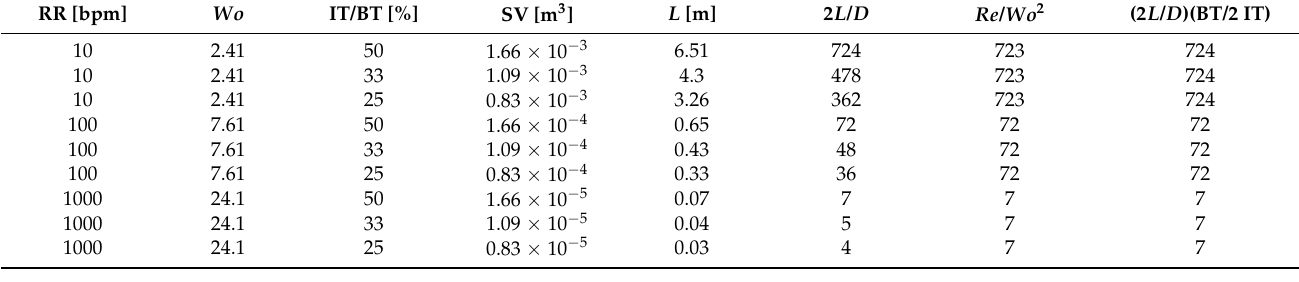
Table 3. Flow regime parameters evaluated at the upper tracheal section (Plane 1): Re / Wo 2 , dimensionless stroke length 2 L / D and modified dimensionless stroke length ( 2 L / D ) (BT/2 IT). Stroke length ( L ) was calculated as: SV/ ( π D 2 /4 ) , where SV = stroke volume and D = tracheal diameter = 0.018 m. SV was obtained by integrating the time-varying volumetric flow rate at the inlet ( Q in ) over a breathing cycle for each Wo and IT/BT condition, where Q in ( t ) = V inlet ( t ) A in (prescribed inlet velocity profile, V inlet ( t ) , refer to (5) and (6)). Reynolds number ( Re ) based on D and mean flow speed in trachea ( U T ) was calculated using an equation defined as: Re = U T D , where U T (=3.4 m s − 1 ). Re was maintained constant at 4200 across all ν test conditions. The Womersley number ( Wo ) was calculated using Equation (1). Note that breathing time (in seconds), BT = (60/RR), where RR = respiratory rate (in bpm).